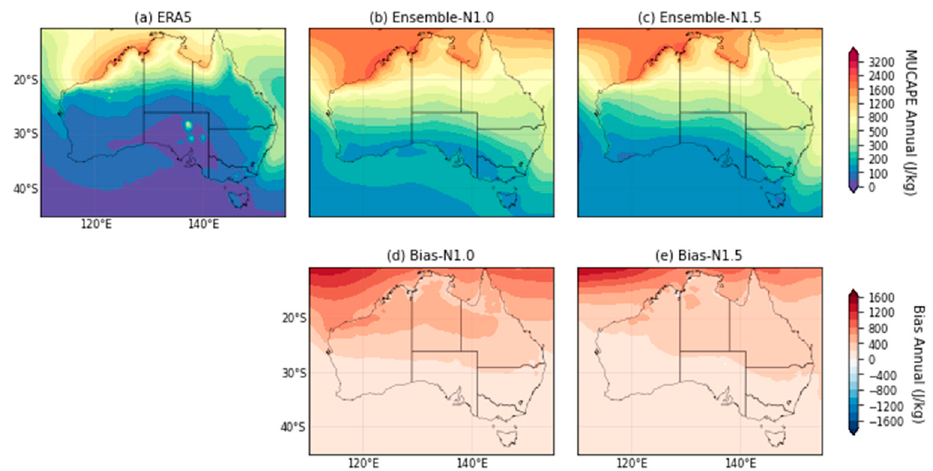
Figure 2. Climatology of the annual MUCAPE in d01 from ( a ) ERA5, ( b ) N1.0 and ( c ) N1.5. ( d , e ) are the biases of N1.0 and N1.5 from ERA5, respectively. Unit: J kg − 1 .